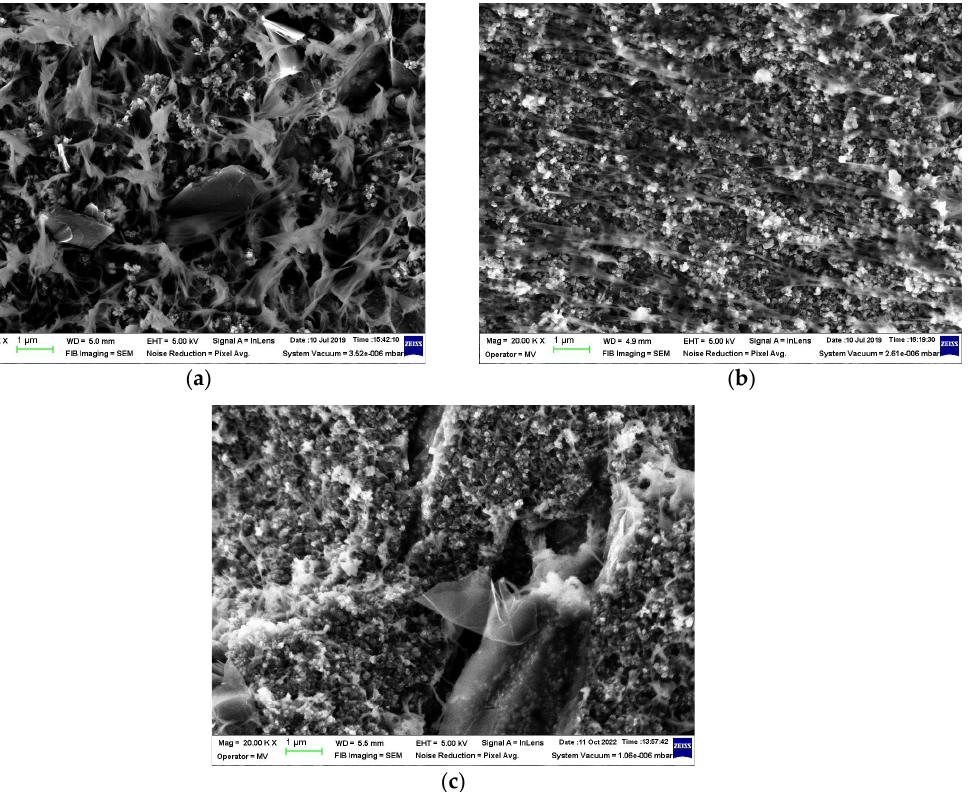
Figure 6. The effect of the preparation procedure on dispersion state of the conductive particles in a polymeric matrix: ( a ) (CB + Gr)/HD composite prepared by melt extrusion; ( b ) (CB + Gr)/HD composite prepared by mold pressing of a powder mixture; ( c ) (CB + Gr)/(LLD + HD) composite prepared by mold pressing of a powder mixture.